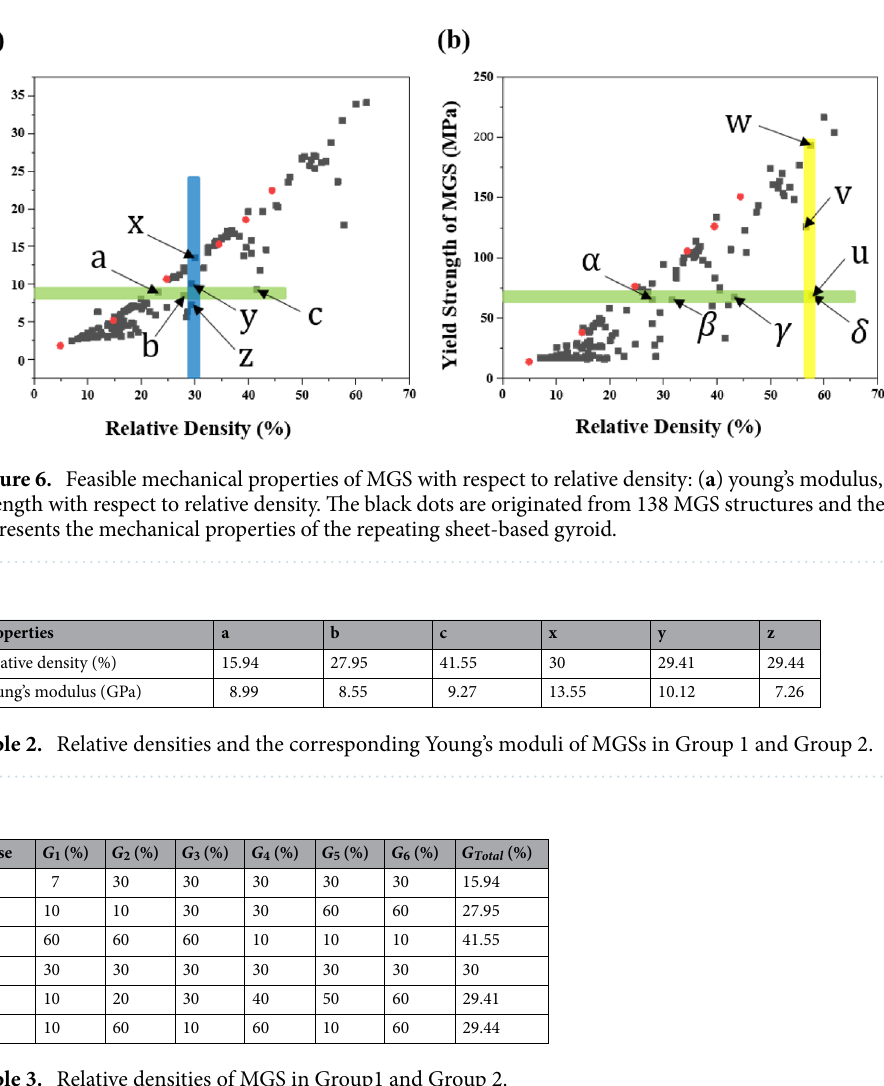
Table 3. Relative densities of MGS in Group1 and Group 2.